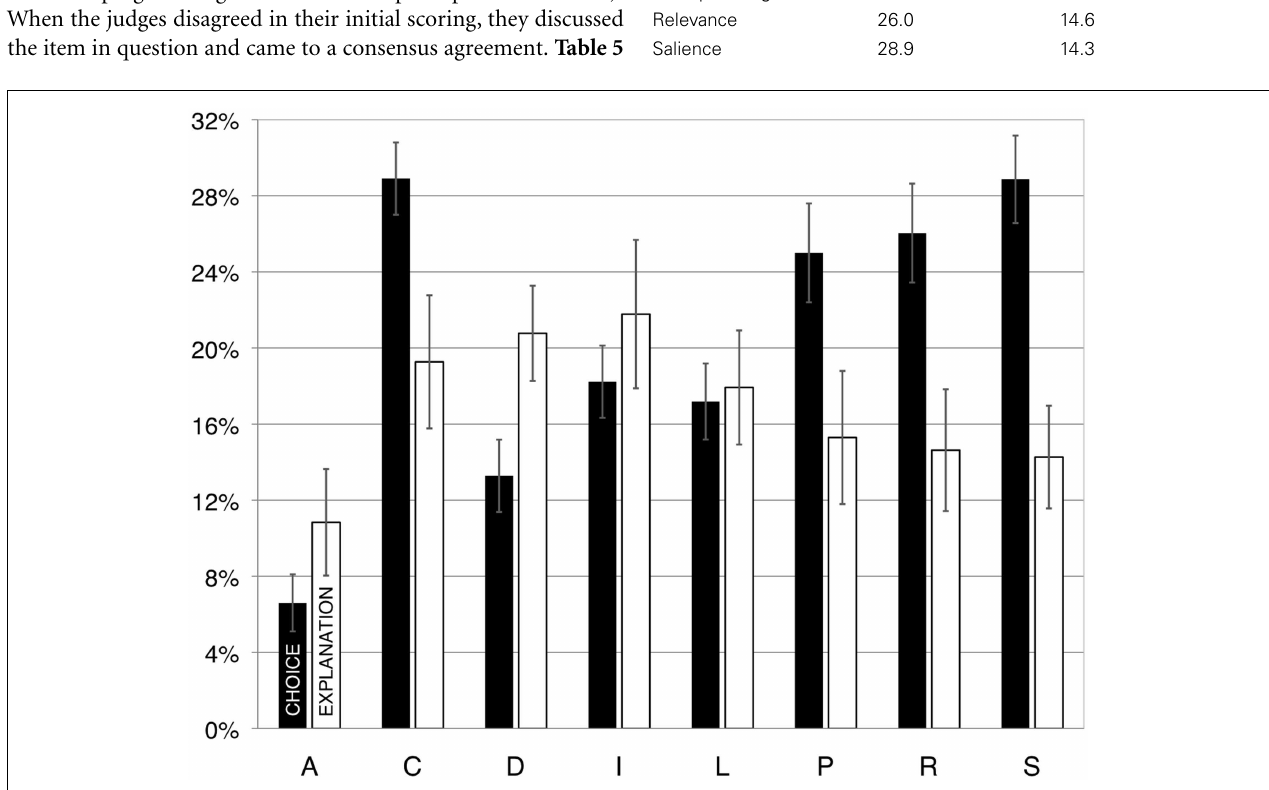
knowledge; C, compatibility; D, discriminability; I, informative change; L, limited capacity; P, perceptual organization; R, relevance; S, salience. Error bars illustrate the standard error of the